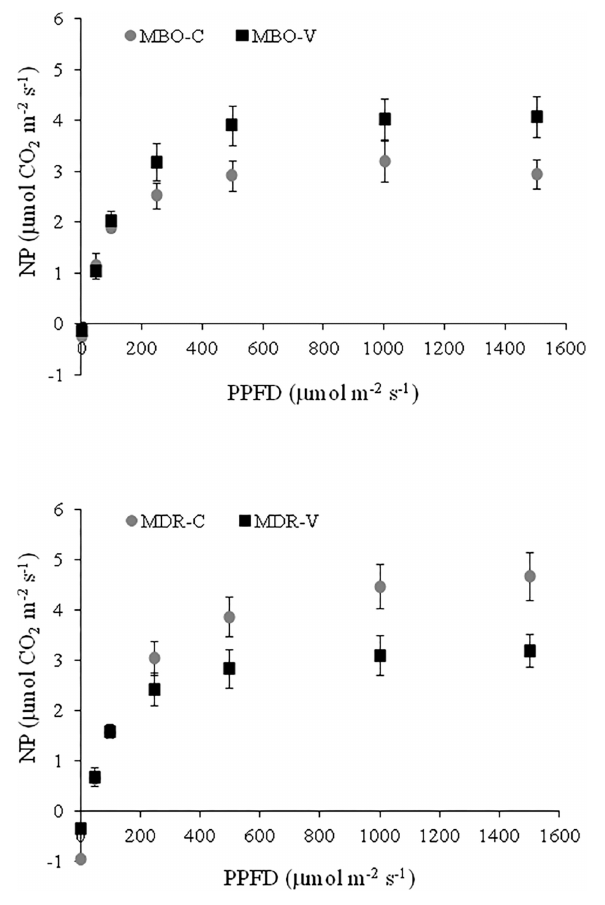
FIGURE 1 | Response curve of leaf net photosynthesis (NP) to increasing white light intensity in plants of Ranunculus asiaticus L. hybrids MBO and MDR, obtained by two preparation procedures of tuberous roots, only rehydration (Control, C) and rehydration plus vernalization (V). Plants at vegetative stage (4th week after planting), grown in a climatic chamber under a controlled environment. Measurement conditions in the leaf chamber: 20 ◦ C, RH 60%, 400 ppm ambient CO 2 concentration. Mean values ± standard errors; n =